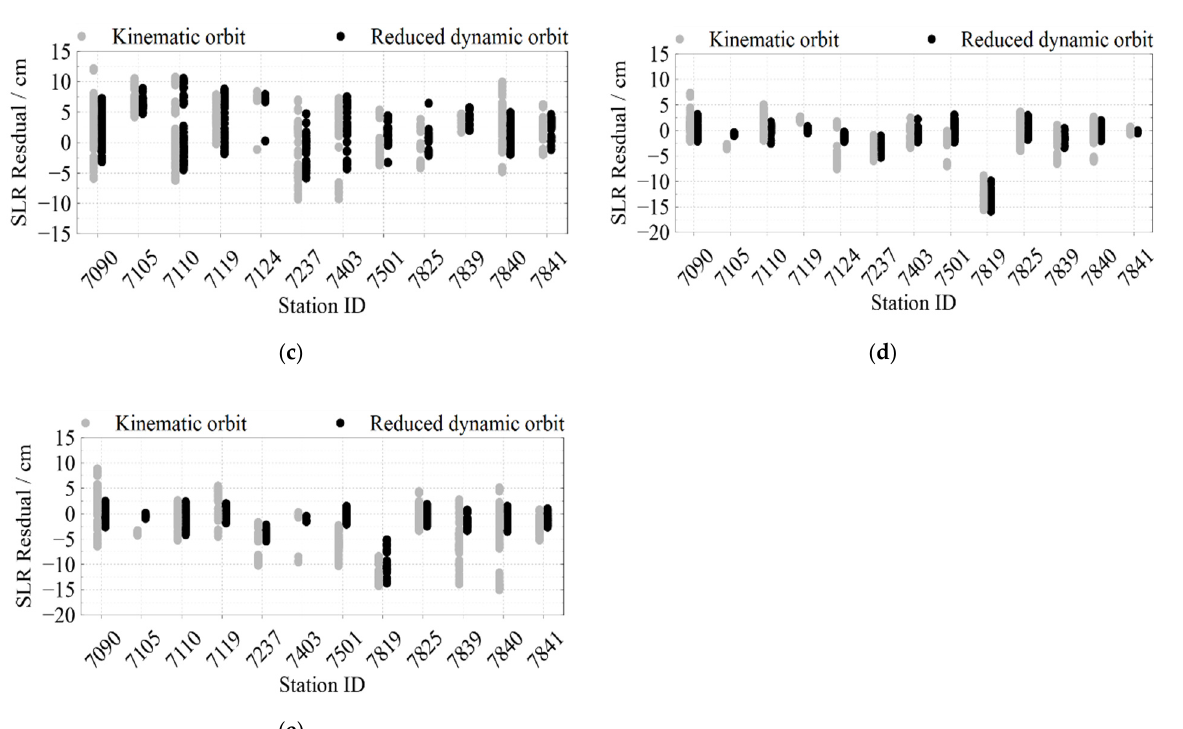
Figure 5. SLR residuals for Swarm and GRACE-FO satellites’ kinematic and reduced dynamic orbits from DOY 152 to 165 in 2021 at each station. ( a ) SLR residuals for Swarm-A; ( b ) SLR residuals for Swarm-B; ( c ) SLR residuals for Swarm-C; ( d ) SLR residuals for GRACE-C; ( e ) SLR residuals for GRACE-D. Gray and black points in ( a – e ) are the residuals of the kinematic orbit and reduced dynamic orbit, respectively. Table 4. Summary for SLR residuals.